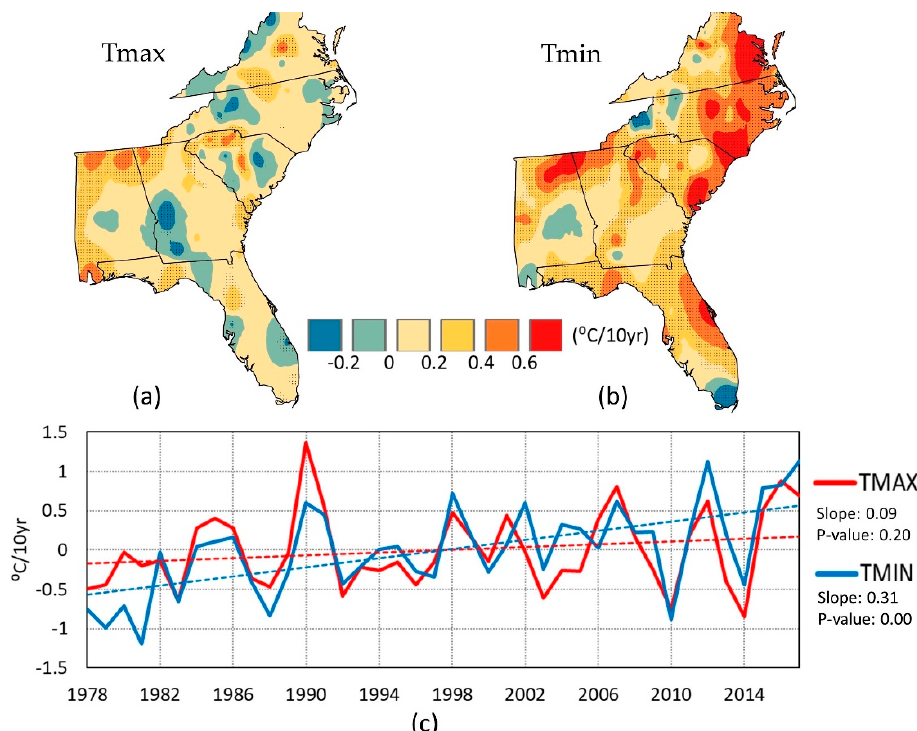
Figure 3. Spatial distribution of decadal temperature trends of the Southeast (1978–2017); stippled areas on the maps indicate trends that are significant at the 5% level ( a ) maximum temperature; ( b ) minimum temperature; ( c ) associated anomaly time series and trendlines.